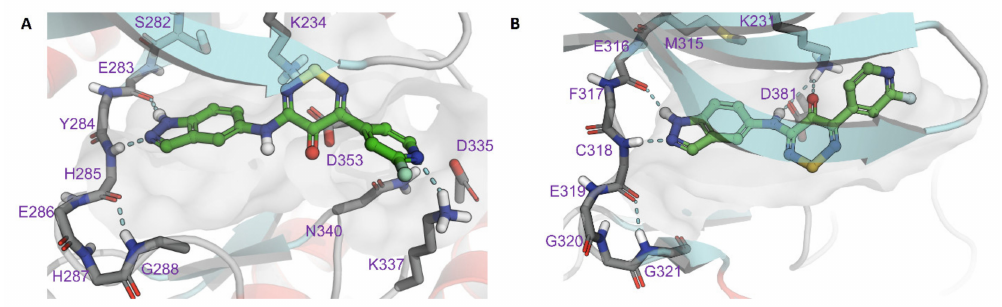
Figure 8. Molecular modeling of thiadiazinone 26 on MIBS kinome profiling hits: ( A ) ACVR1B and ( B )